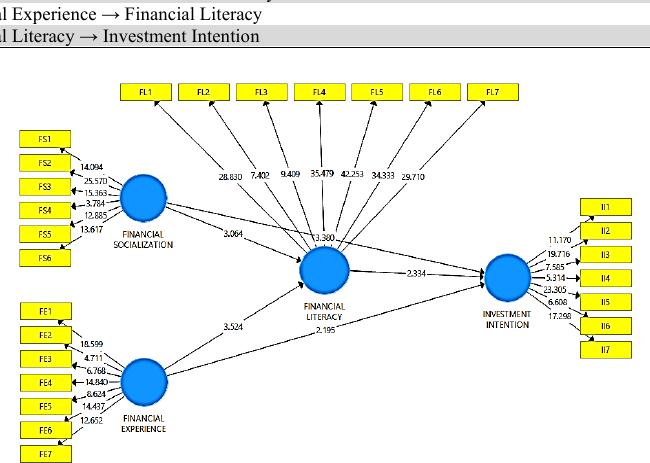
Fig. 2. Structural model — overall path